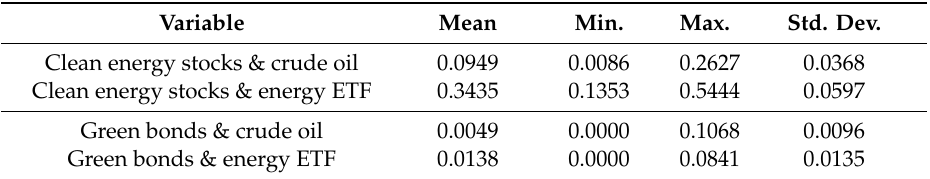
Table 4. Summary statistics of hedge e ff